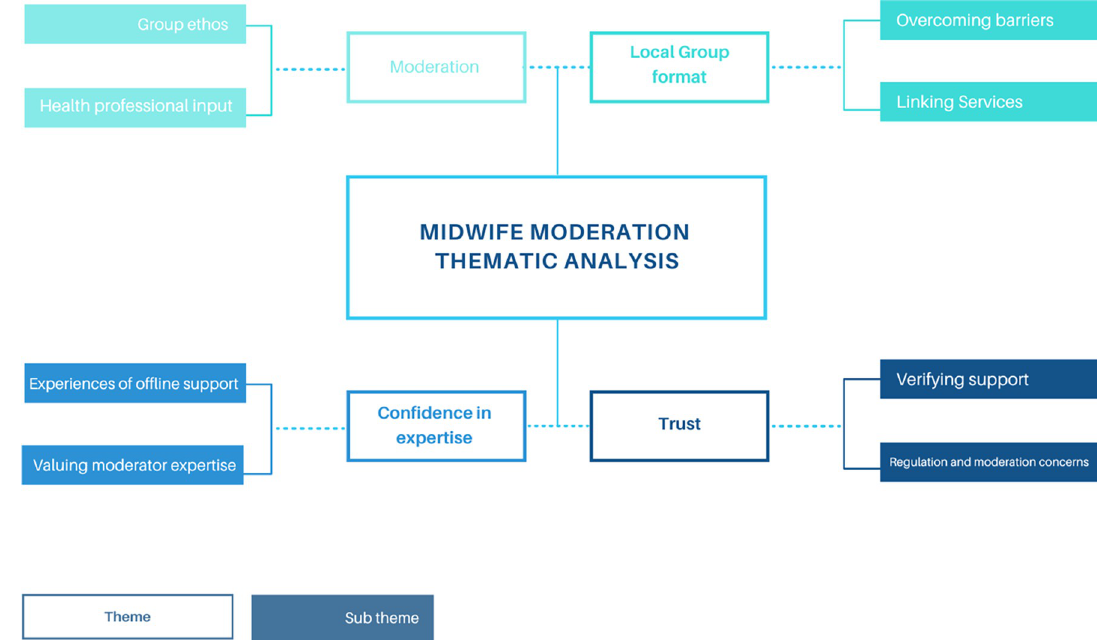
Fig 4. Themes arising from thematic analysis of mothers’ experiences of midwife